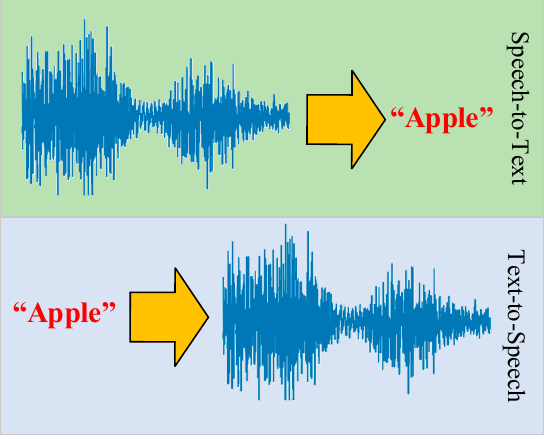
Figure A1. Architecture of the VGG16 model.